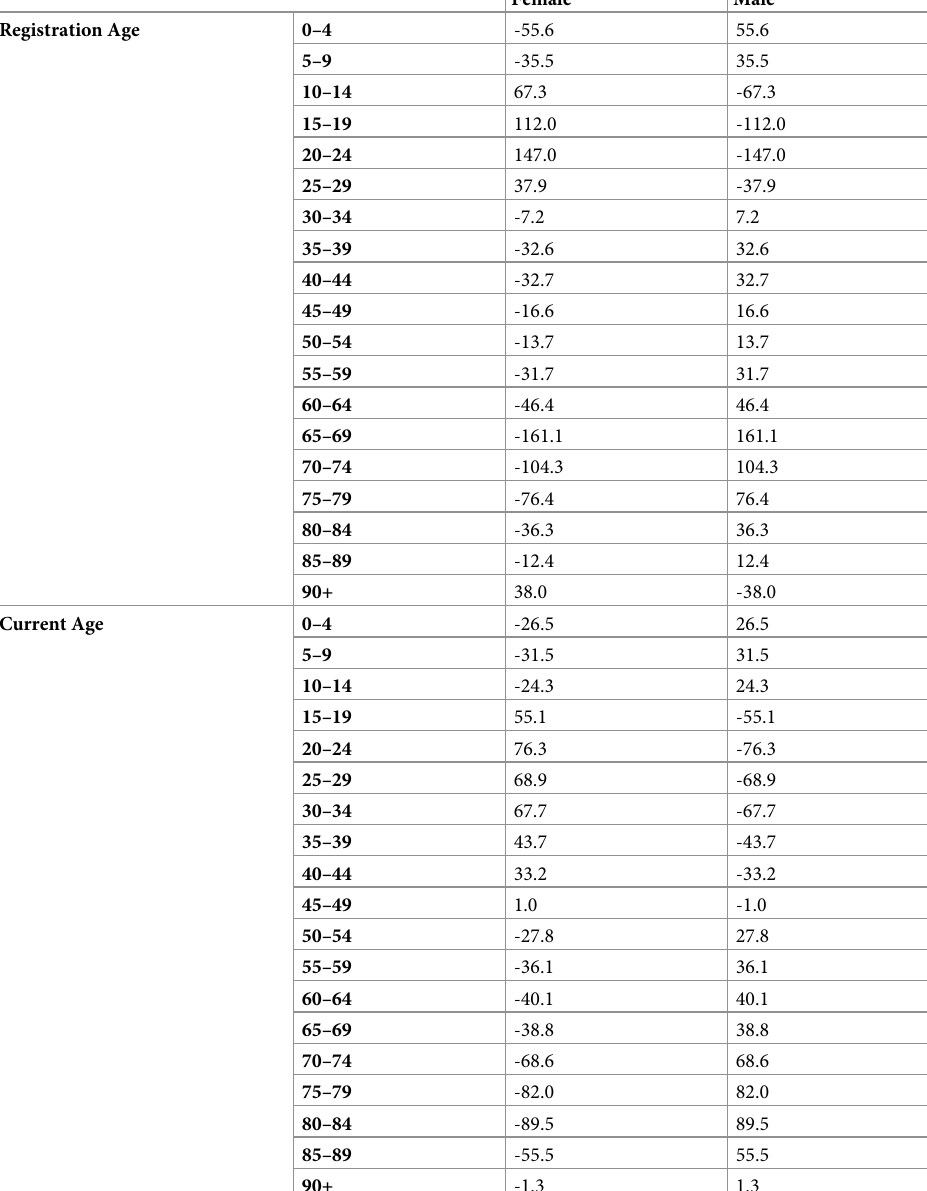
Table 4. Chi 2 test of independence adjusted residuals for gender and age groups (analysed using dataset 1 –March